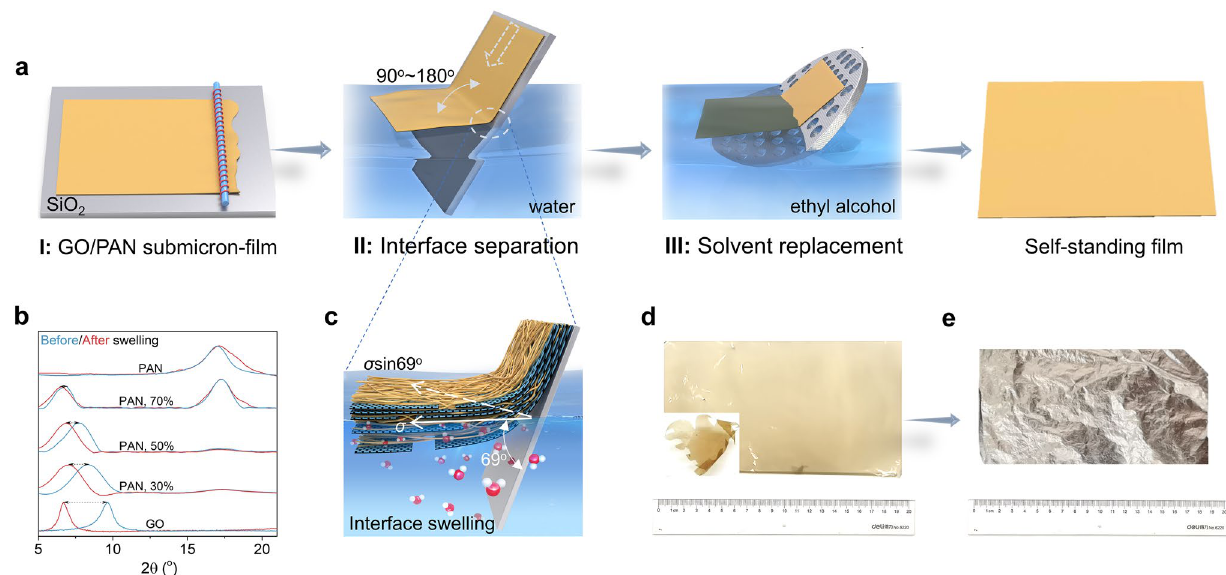
Fig. 1 Preparation of ultrathin free-standing GO/PAN film. a Preparation process of a self-standing GO/PAN film. b XRD spectra of GO/PAN films with different mass ratios before and after swelling in water. c Detachment of GO/PAN film from the quartz substrate on the water surface (Step II). d Images of free-standing GO/PAN film (190 nm thick) with a large area and having the ‘Qiushi eagle’ shape (corner). e Free-standing nMAG (100 nm thick) treated under argon atmosphere at 3,000 °C for 1